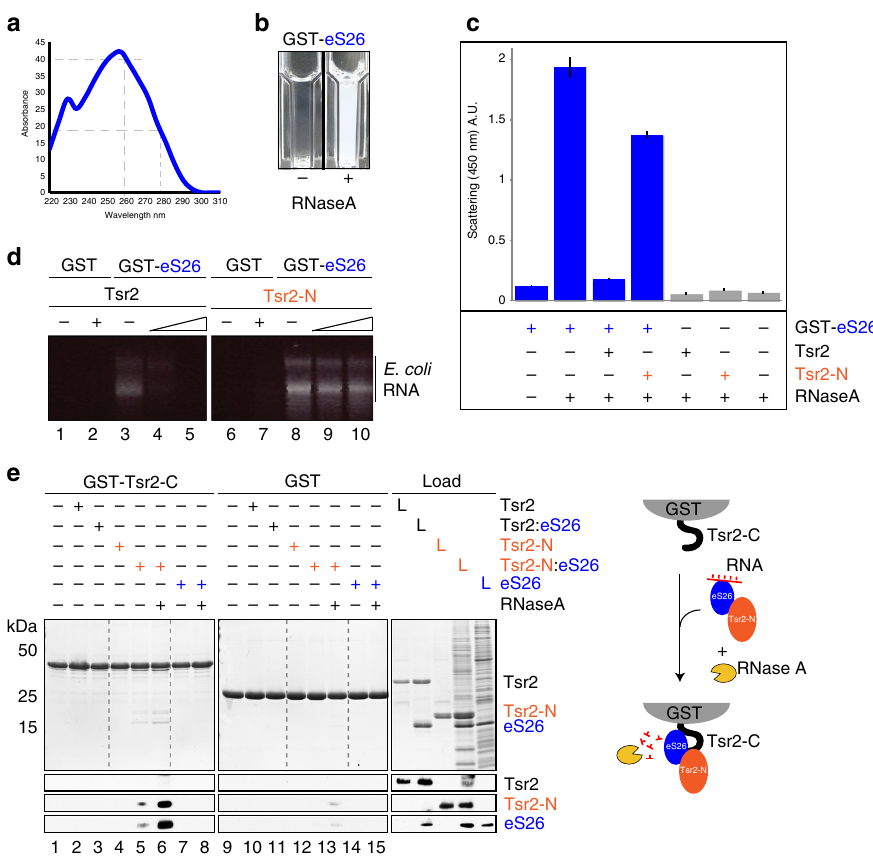
Fig. 6 C-terminal acidic tail of Tsr2 keeps eS26-RNA free. a eS26 co-enriches nucleic acids. b RNase A triggers aggregation of eS26. GST-eS26 was treated with RNase A and incubated for 10 min at RT in a photometric cuvette. c Tsr2 prevents aggregation of recombinant eS26 in vitro. Thirty-three micromolar GST-eS26 and a two-fold concentration of Tsr2 (66 µ M) in PBSKMT was pre-incubated for 1 h at 4 °C ( fi nal volume: 90 µ l). One microgram of RNase A was added to initiate aggregation. After 1 h of incubation, the scattering signal of the aggregated eS26 was monitored at 450 nm ( Y -axes). Three replicates for each well were measured. The error bars show the standard deviation. d Tsr2 releases RNA bound to GST-eS26. RNA was extracted from immobilized GST-eS26 after addition of increasing amounts of Tsr2 or Tsr2-N, respectively, separated on a 1% agarose gel and stained by EtBr. e GST-Tsr2-C was immobilized on Glutathione Sepharose before incubation with puri fi ed Tsr2, Tsr2-N or/and an E. coli lysate containing recombinant eS26 in the presence or absence of RNaseA. L = input (1:10